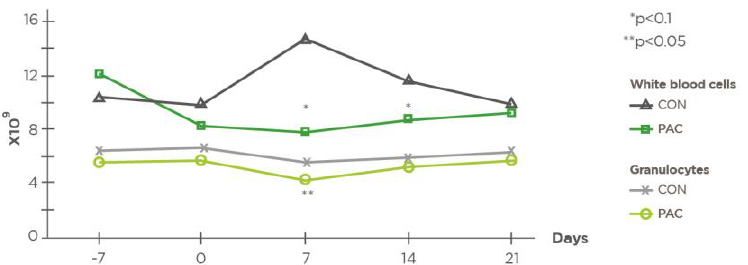
Figure 2. Effect of plant bioactive compounds on total number of white blood cells and granulocytes ( n = 23).